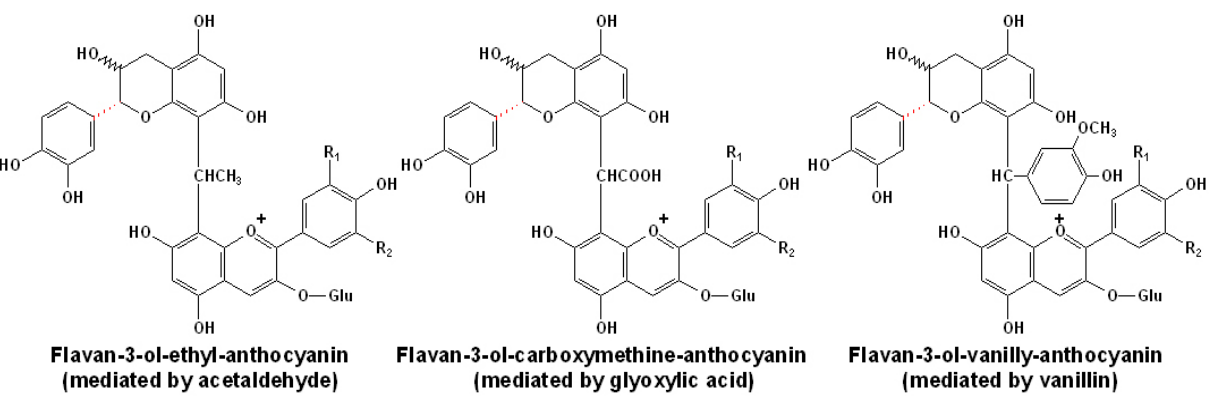
Figure 6. Structures of some mediated condensed oligomeric anthocyanins